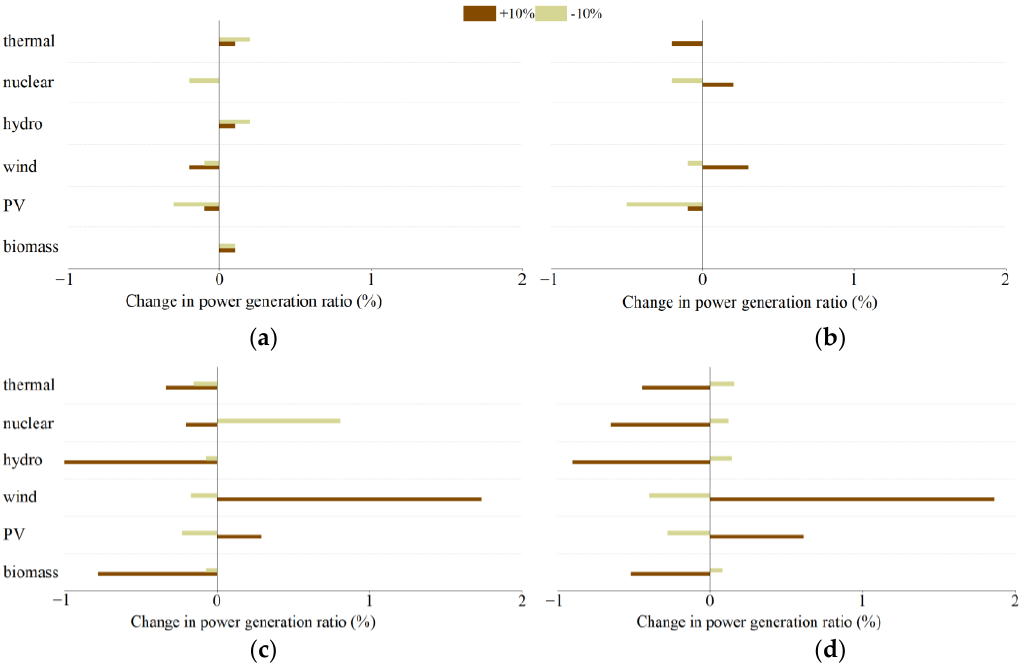
Figure 11. Sensitivity Analysis of Key Parameters. ( a ) Non-carbon external cost, ( b ) Learning rate of LCOE, ( c ) Reserve factor, ( d ) Non-fossil cumulative intalled capacity ratio.